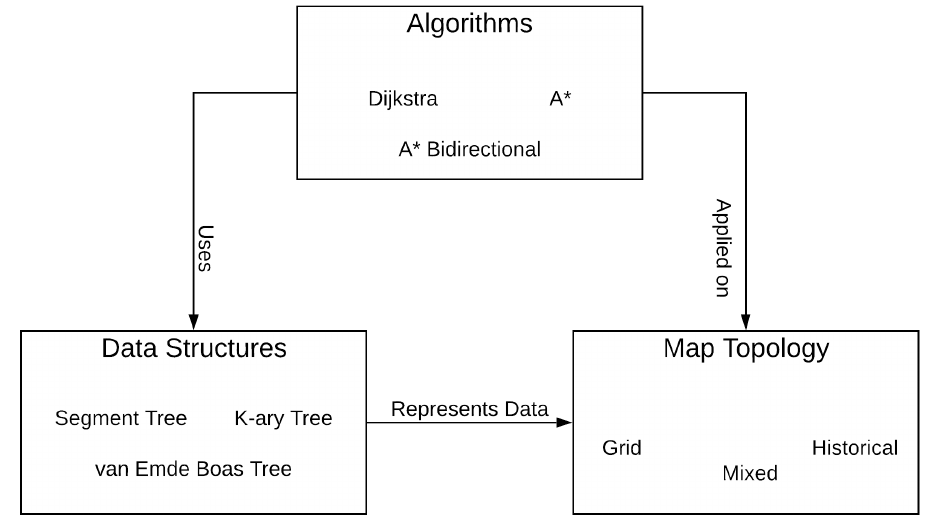
Figure 1. Vehicle to Cloud Congestion Prediction